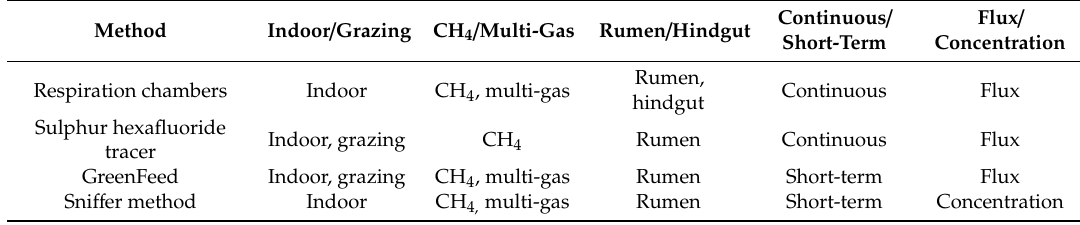
Table 1. Comparison of enteric CH 4 emission measurement